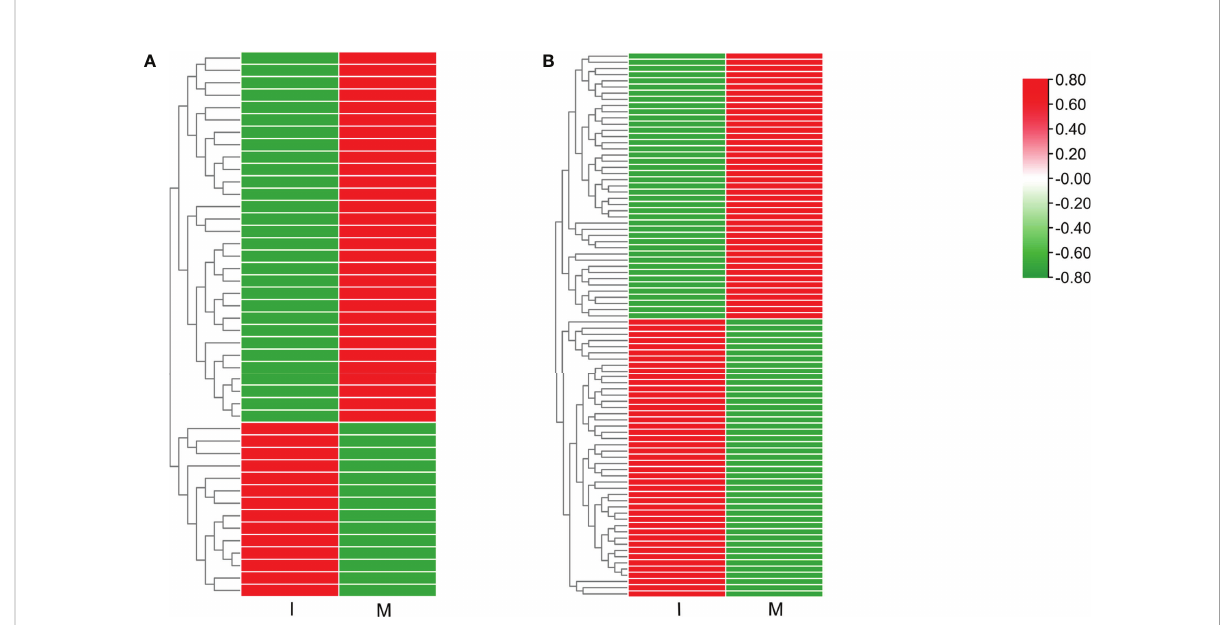
FIGURE 6 CYPs and ABC transporters involved in the synthesis of steroid alkaloids. (A) CYPs. (B) ABC transporters. Red color denoted genes with high expression level, while green color denoted genes with low expression level. The relative expression levels of DEGs were calculated using log 2